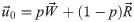
The effects of initial conditions and dimensionality.Comparison over dimensionality and random initial condition. A Transition from random to domain wall initial condition. We let the initial condition u→0=pW→+(1-p)R→ where W→ is the domain wall I.C. and R→ is the random I.C., hence p can be thought of as a spatial correlation measure. Two lengths L = 50, 100 are shown. The simulation was done in 1D and 50 simulations were done per point. The error bars correspond to plus or minus two standard deviations. B Distribution of extinction times by dimension. Dimensionless parameters used γU = γV = 0.5, a = 0.9, σ = 2, β = 5, c = 0.5, r = 0.9, ϵ = 2 × 10−3.